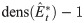
Observed dominance, robustness and density at the balance point of time-varying networks as the networks grows in size over time.To improve the presentation, we plot dens(E^t*)−1 for the density measure.